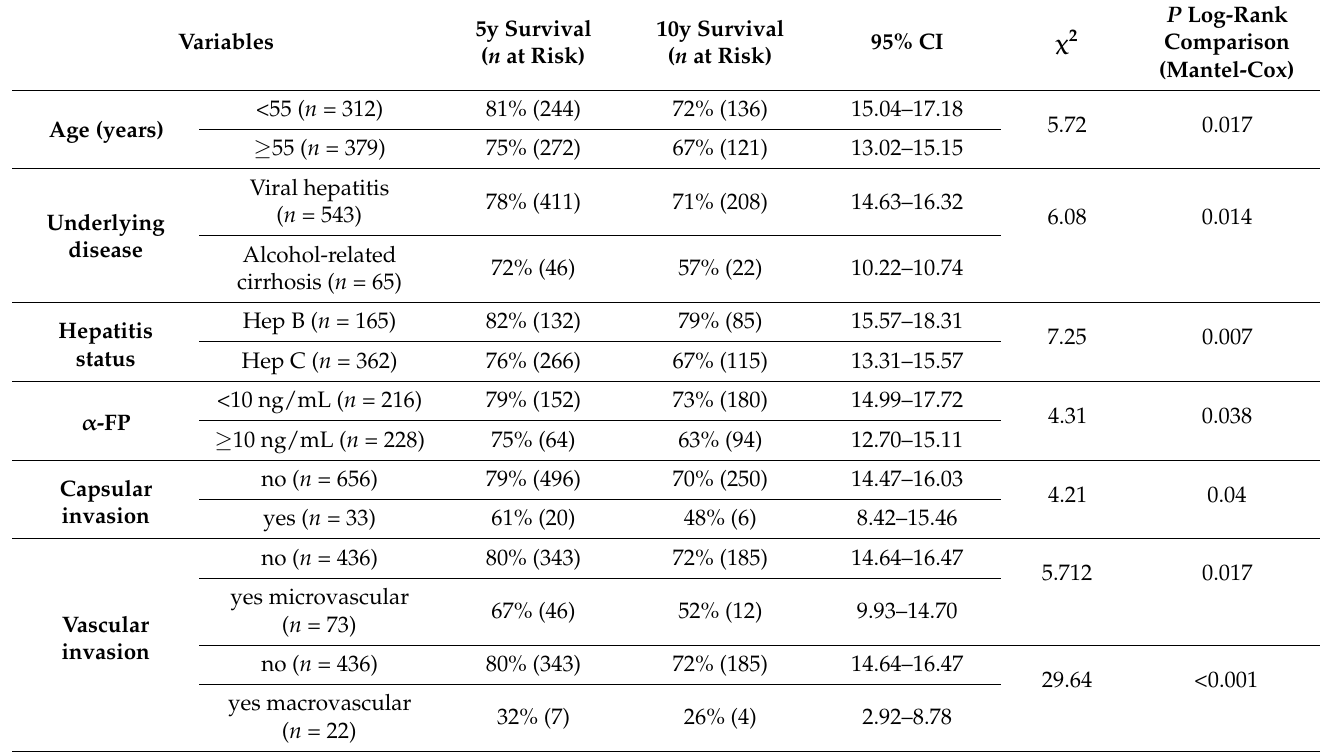
Table 2. Factors influencing overall survival (Abbreviations: CI – Confidence interval; α -FP—alpha- fetoprotein).